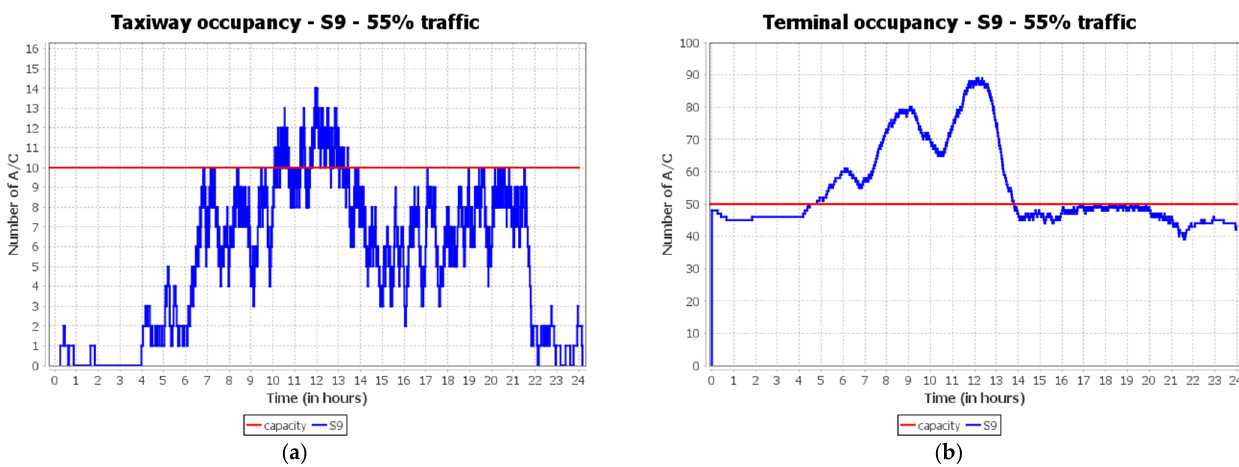
Figure 14. Taxiway ( a ) and terminal ( b ) occupancy scenario S9.